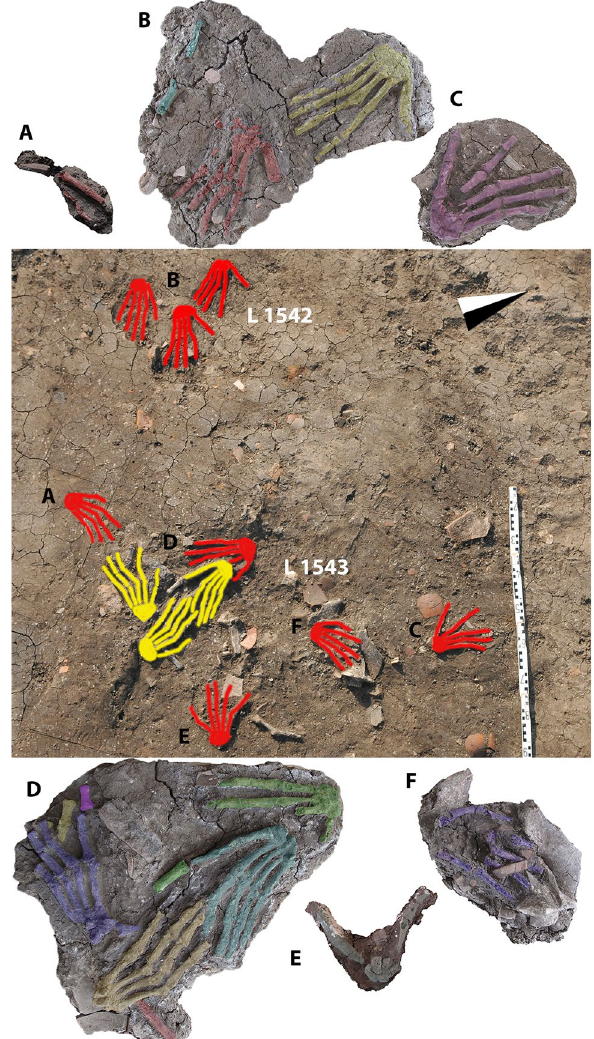
Figure 2. Anthropological reconstruction of the finding and details of the right hands of Pits L1542, L1543 (reconstruction and images of single hands, J. Gresky): reconstruction of the complete hands in the Pits L1542 (left upper corner) and L1543 (lower half of the picture). Yellow hands are placed on their dorsal surface whereas the red ones are placed on their palmar. The missing elements are reconstructed. ( A , C – F ) eight right hands of Pit L1543, together with single phalanges which could either represent additional hands or might belong to the present hands. The preserved bones are coloured. ( B ) Three right hands on their palmar surface in Pit L1542. The preserved bones are